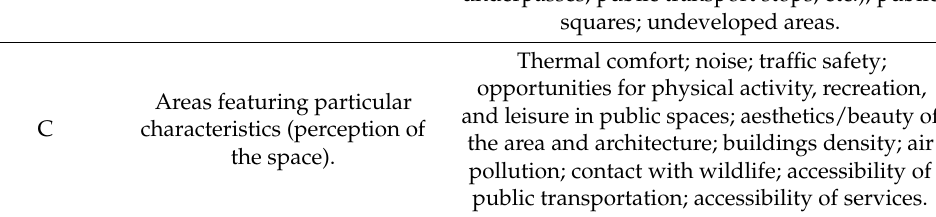
Table 2. Categories of data collected during the study using the geo-questionnaire. Group Theme Features Assessment of the changes in Positive changes, negative changes. A the area in the last ten years. Urban green areas (including sport and recreation); transportation areas (roads, Expected changes in the area sidewalks, bicycle paths, pedestrian crossings, B with a following land use. underpasses, public transport stops, etc.); public squares; undeveloped areas. Thermal comfort; noise; traffic safety; opportunities for physical activity, recreation, Areas featuring particular and leisure in public spaces; aesthetics/beauty of C characteristics (perception of the area and architecture; buildings density; air the space). pollution; contact with wildlife; accessibility of public transportation; accessibility of